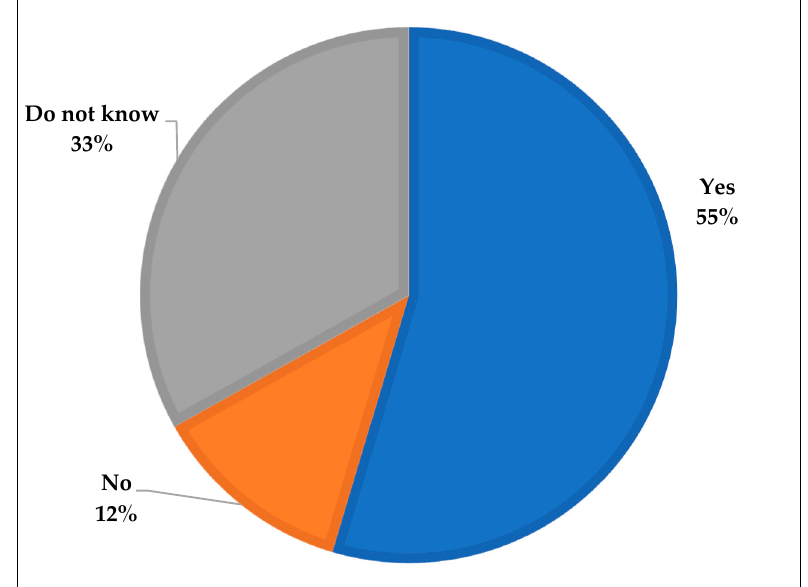
Figure 10. Percentage of housing designed by an engineering consultation office.